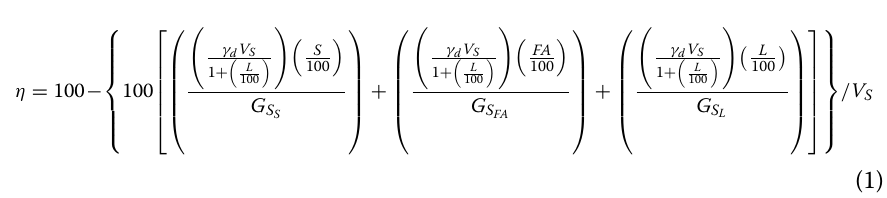
Fig. 11 Effect of salt content on lime and fly ash treated